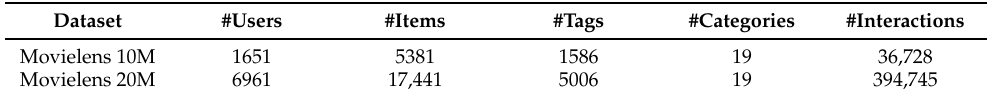
Table 1. Statistical information of experimental